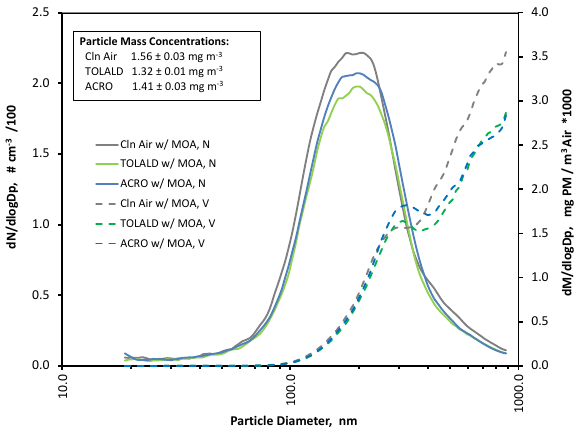
Fig. 2. MOA particle number and mass size distributions from the SMPS during Clean Air and single-VOC experiments. Particle mass concentrations reported in the inset were determined from TSP filter measurements.